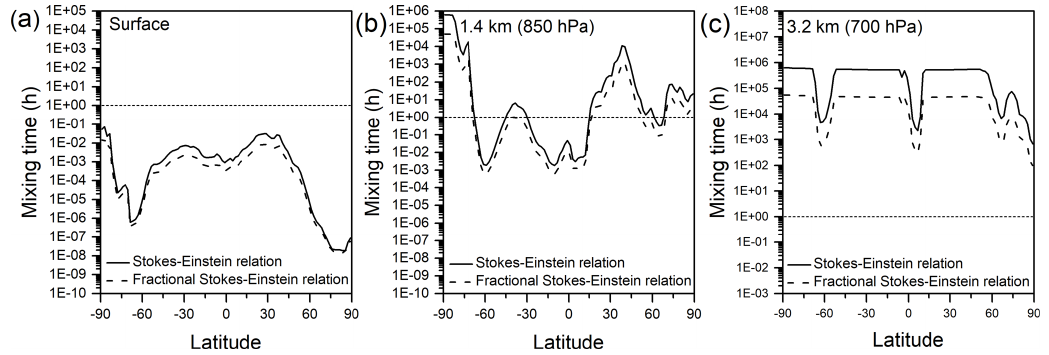
Figure 5. Mixing times (in hours) of organic molecules in 200nm SOA particles at (a) the surface, (b) 850hPa or ∼ 1 . 4km of altitude, and (c) 700hPa or ∼ 3 . 2km of altitude using diffusion coefficients calculated with the Stokes–Einstein relation (solid black lines) and the fractional Stokes–Einstein relation (dashed black lines). A 1h mixing time, which is often assumed in chemical transport models, is also indicated in each figure with a horizontal dotted